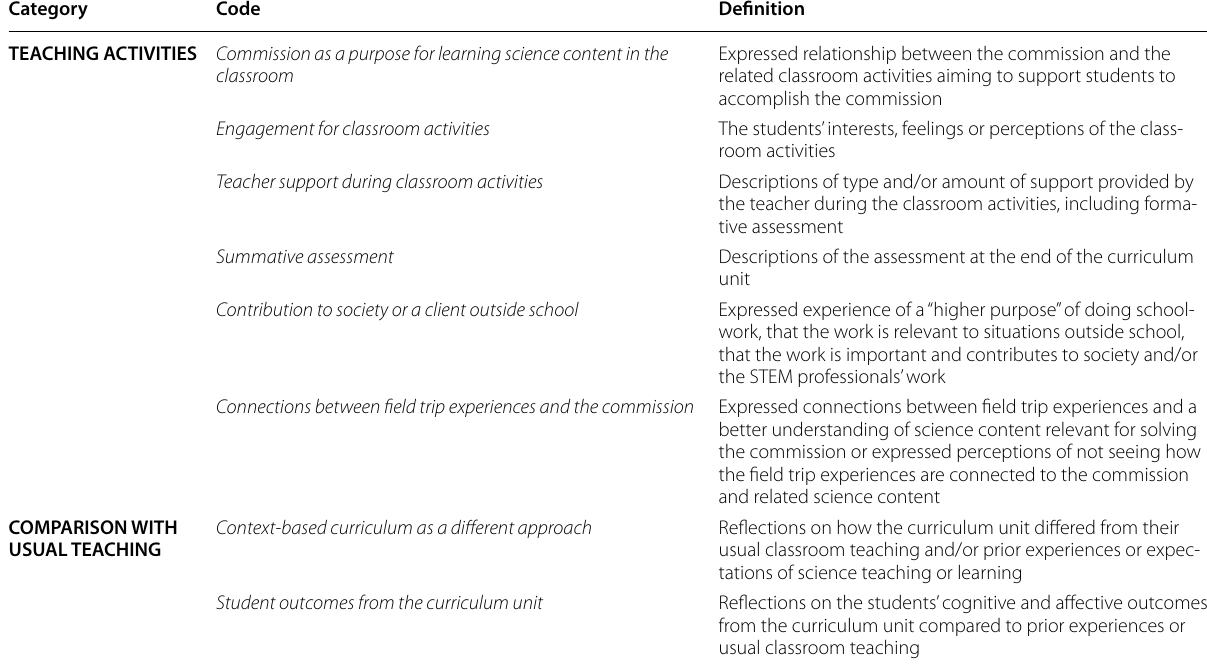
Table 2 Overview of categories and codes with definitions Category